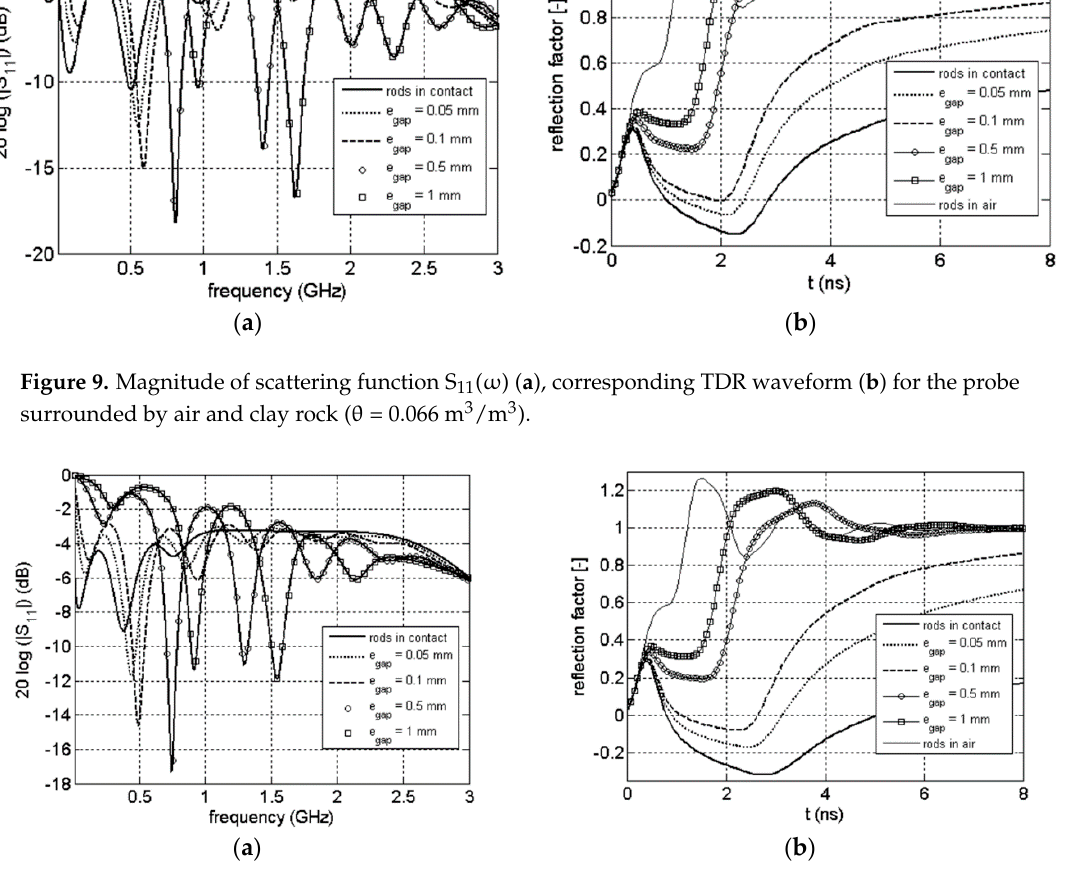
Figure 10. Magnitude of scattering function S 11 ( ω ) ( a ), corresponding TDR waveform ( b ) for the probe surrounded by air and clay rock ( θ = 0.157 m 3 /m 3 ).